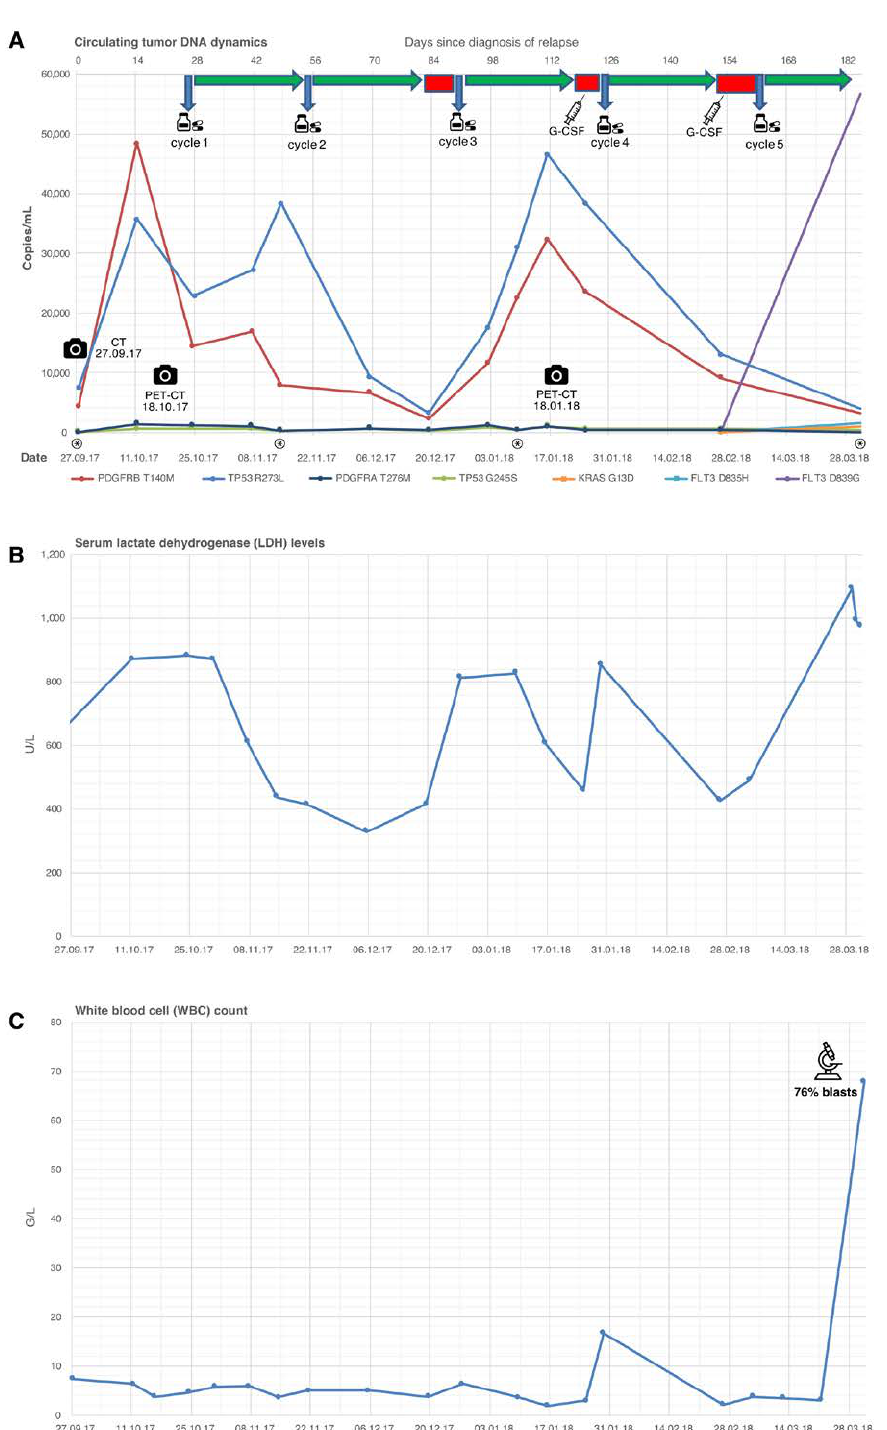
Figure 3. Time course of patient’s disease and treatment. ( A ) Amount of ctDNA in the patient’s blood in copies per milliliter. Above the diagram, the therapy regimen is shown. Blue vertical arrow/pill box, first day of each new treatment cycle; green arrow, treatment period; red box, therapy interruption due to neutropenia; syringe, administration of short-acting granulocyte colony- stimulating factor; camera, clinical imaging (CT and PET-CT, see Figure 2). The four time points with targeted NGS of cfDNA are marked with a circled asterisk. ( B ) Levels of serum lactate dehydrogenase (LDH). The upper limit of normal is 244 U/L. ( C ) White blood cell count (leukocyte